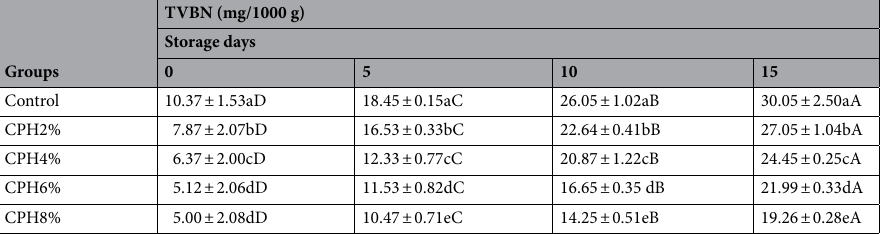
Table 3. TVBN of casein protein hydrolysate (CPH) incorporated beef nuggets during storage. CPH: casein protein hydrolysate. All the values are means of triplicate determinations ± Standard Deviation (SD). Means within the column with different small letters are significantly different (p < 0.05) and different capital letters within the row differed significantly.